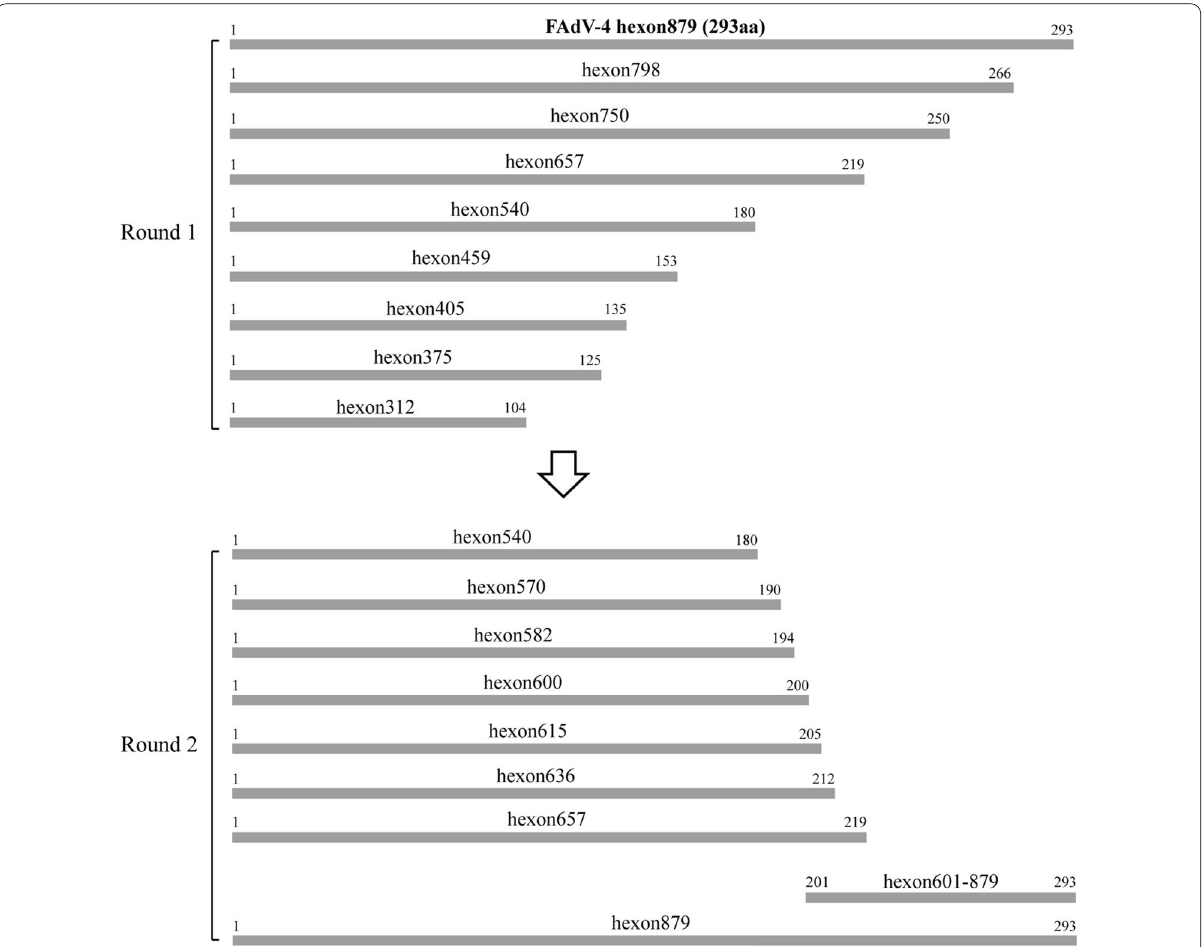
Fig. 2 Schematic representation of FAdV-4 Hexon fragments used for epitope mapping. Two rounds of truncated Hexon proteins were conducted to investigate the epitope of the generated